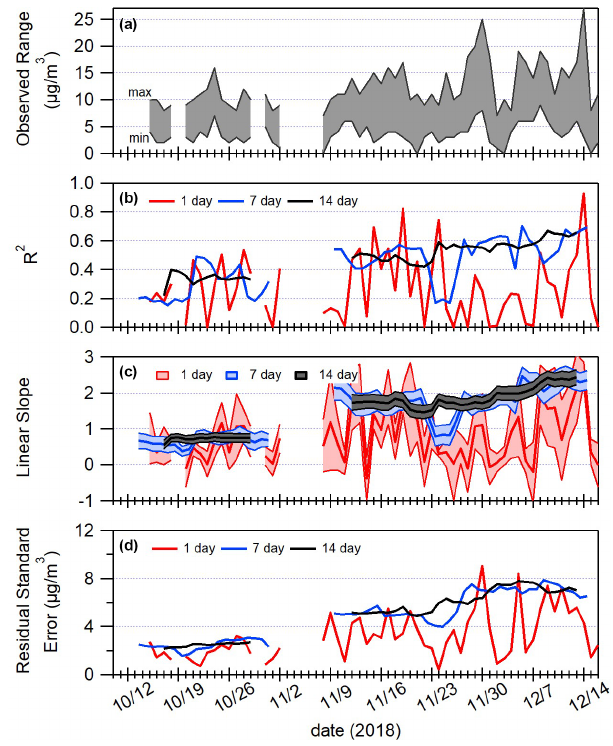
Figure 6. Linear regression parameters from 1h measurements over a 2-month period in 2018. Panel (a) shows the range of measure- ments observed on each day. Panels (b) – (d) show the R 2 , slope, and residual standard error, respectively. In (b) – (d) a rolling collection of 1, 7, or 14d of data was used to find linear regression